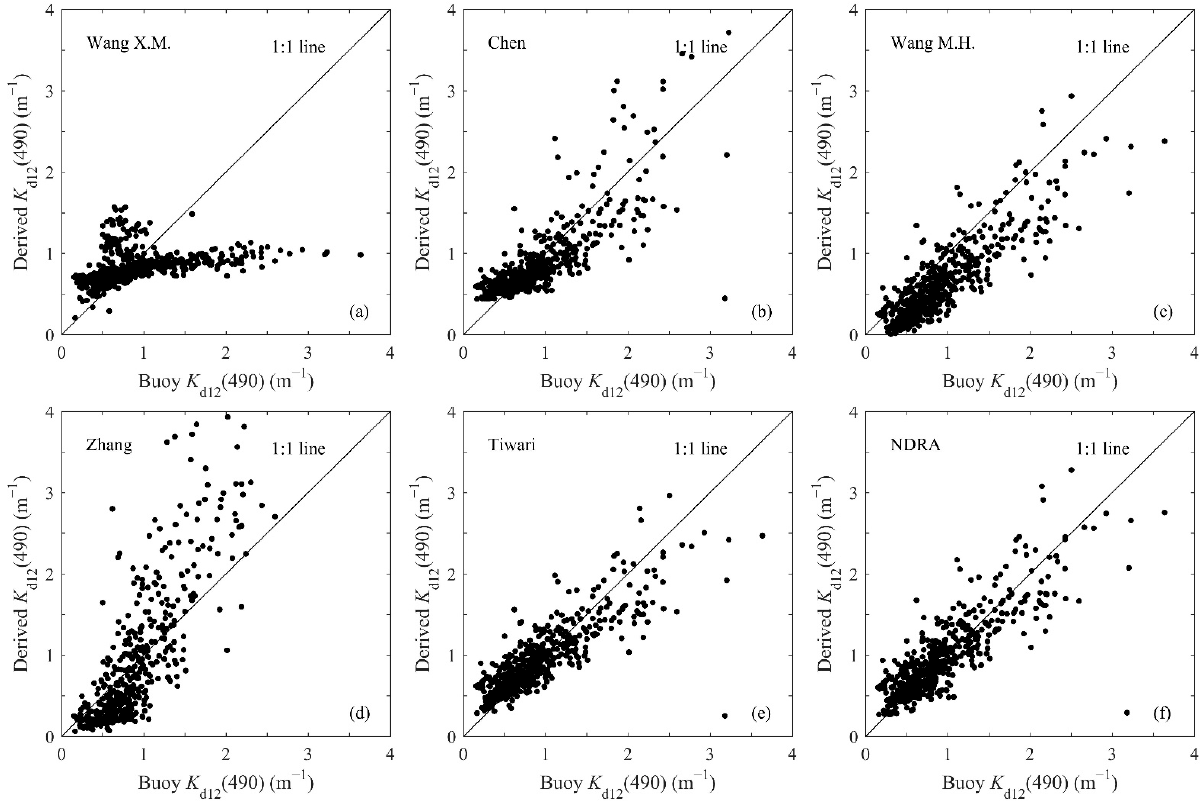
Figure 7. In situ buoy K d12 ( 490 ) versus derived K d ( 490 ) for ( a ) the Wang X.M. algorithm, ( b ) Chen algorithm, ( c ) Wang M.H. algorithm, ( d ) Zhang algorithm, ( e ) Tiwari algorithm and ( f ) NDRA, applied to validation datasets.